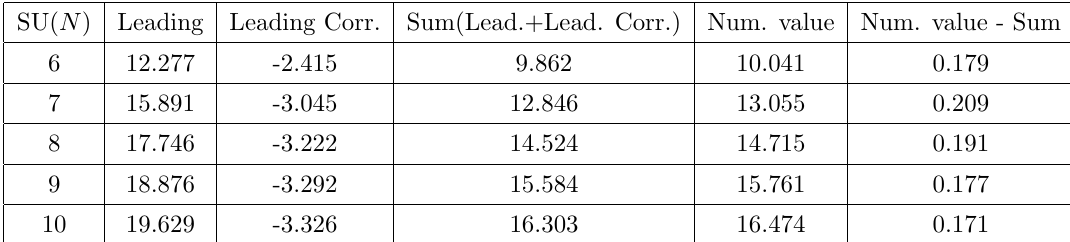
N 10). (cid:20) (cid:20)